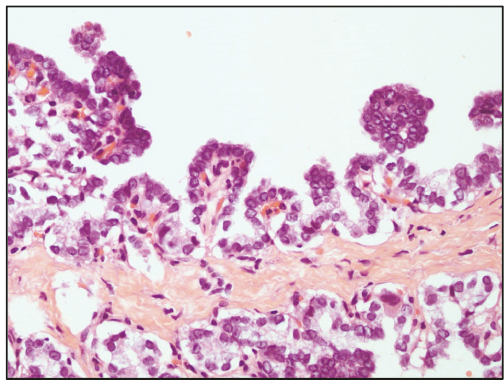
Figure 2: High power (40x) microscopy of the lateral neck mass showing papillary thyroid carcinoma